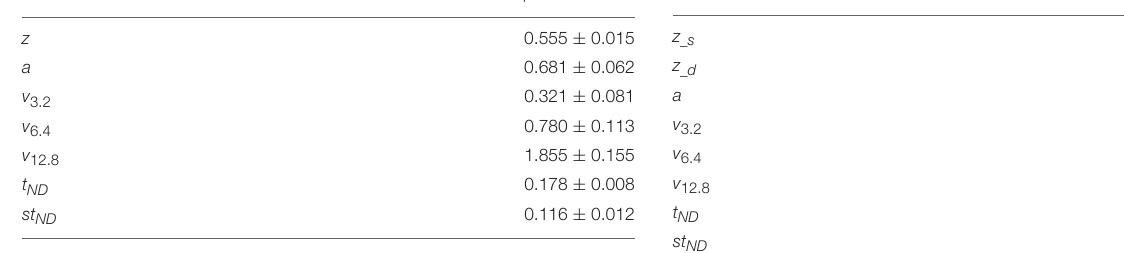
TABLE 3 | Fitted parameters (mean ± SE) of the third DDM (model z ).